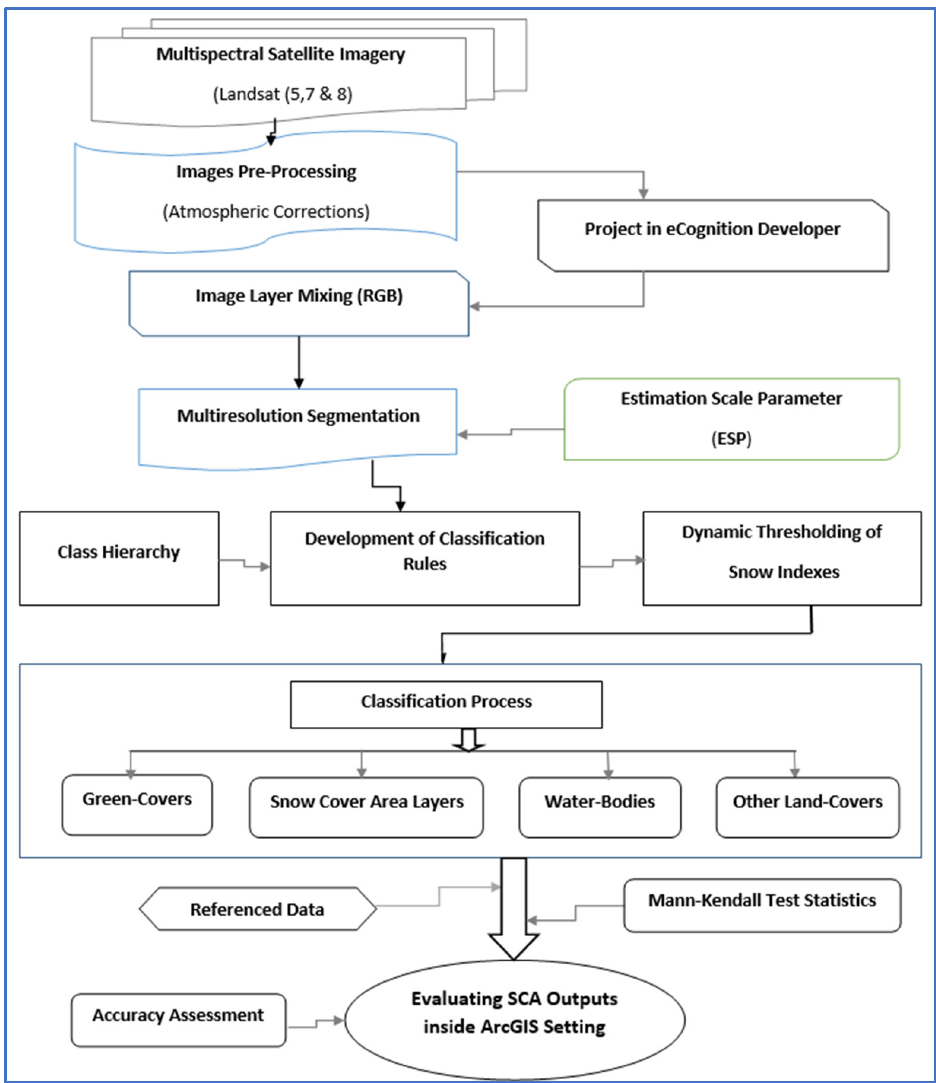
Figure A1. The workflow of the extraction of SCA maps.